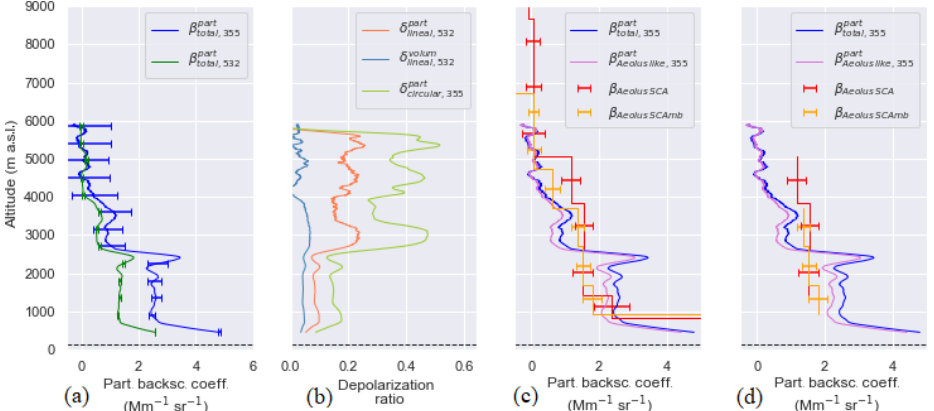
Figure 12. Vertical profiles for the case study in Barcelona on 2 July 2019: (a) ground-based particle backscatter coefficient profiles at 355 and 532nm with their uncertainties; (b) ground-based volume and linear particle depolarization ratios at 532nm and the derived circular particle depolarization ratio at 355nm; (c) Aeolus SCA and SCAmb co-polar particle backscatter coefficients (without quality flags) and the corresponding ground-based Aeolus-like backscatter coefficient. Panel (d) is the same as panel (c) but considering preliminary quality flags. Ground-based lidar profiles were obtained from the continuous measurement of the system from 17:09 to 18:09UTC. Satellite-based profiles correspond to the Aeolus overpass at